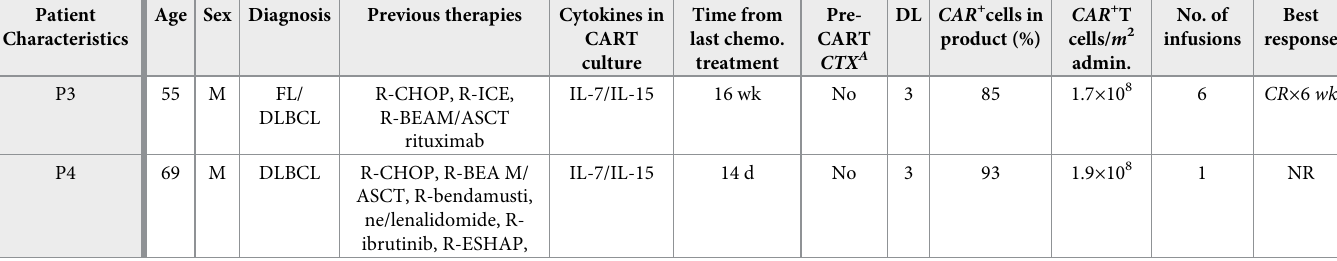
Table 2. Characteristics of patients with NHL or CLL